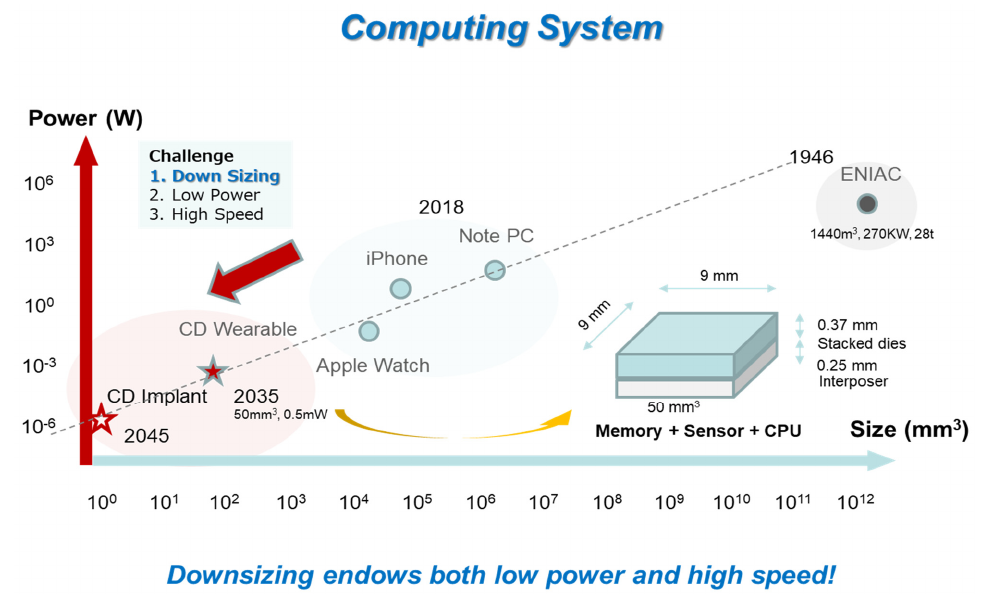
Figure 28. Computing system roadmap for the power consumtion as a function of system volume.